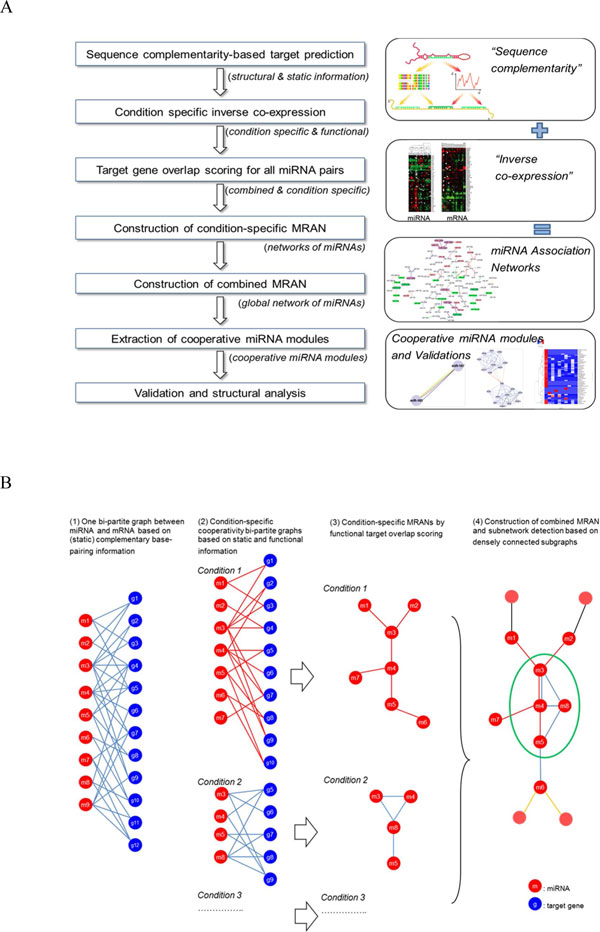
Overview of identifying CMMs in MRAN. (A) The conceptual diagram shows the stepwise process by which our methodology identifies cooperativity of miRNAs. The problem statement is outlined in the right column of the figure. (B) Schematic view of our approach to create miRNA association network and then to identify cooperatively regulating miRNAs in the miRNA association network.